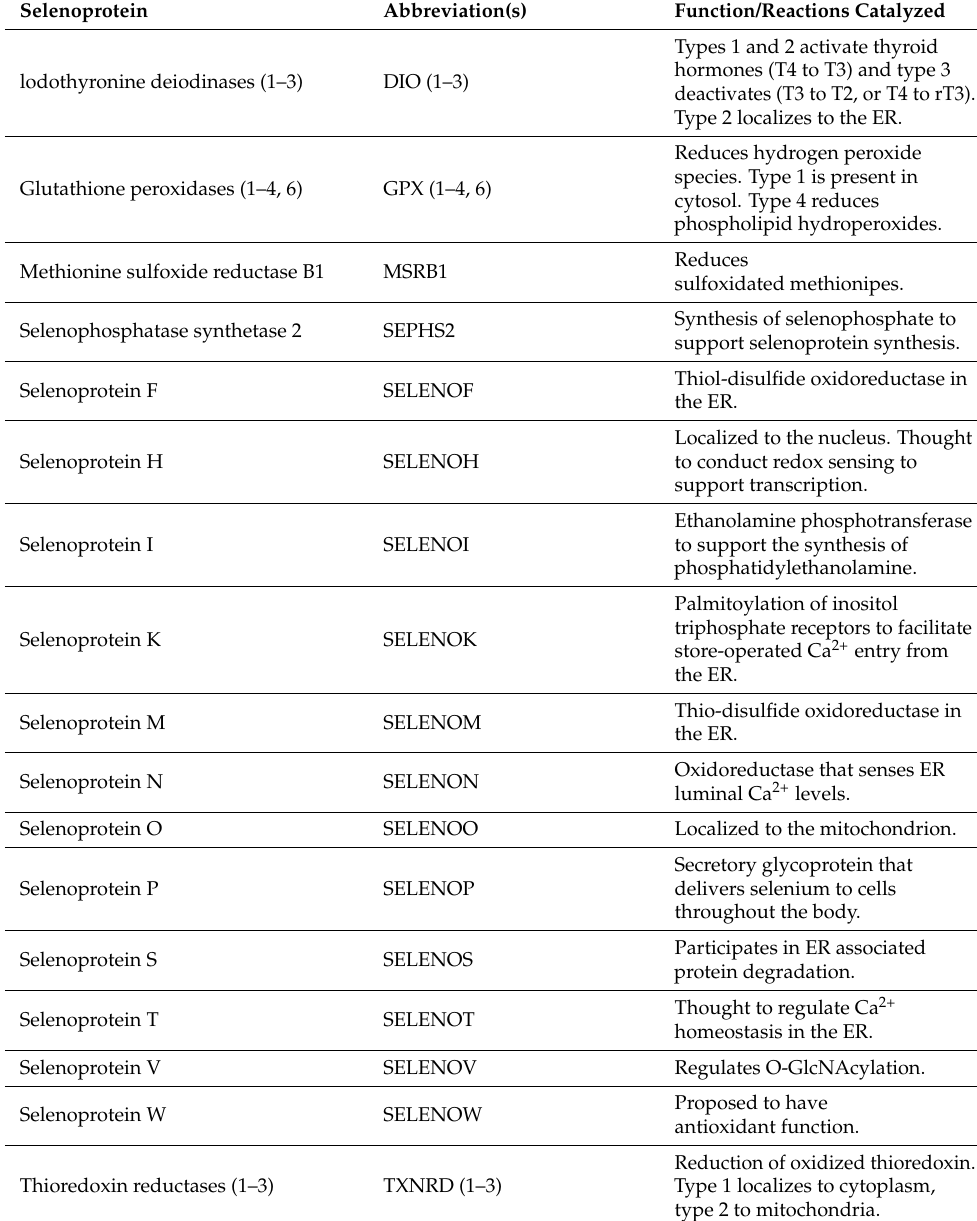
Table 1. Selenoprotein names and